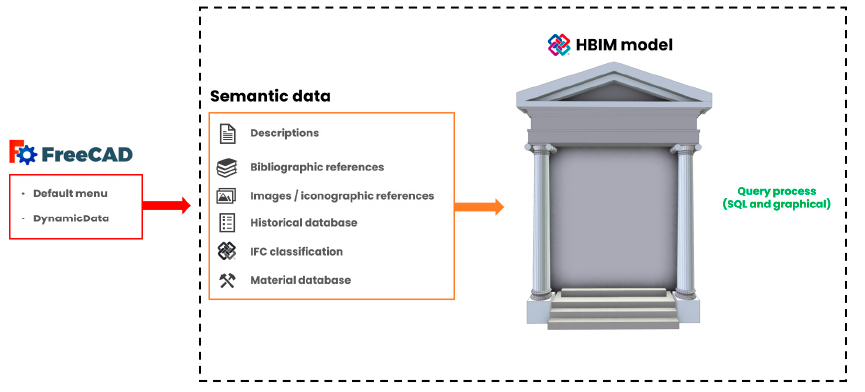
Figure 8. Semantic data inclusion is essential for query processes. Default menu and DynamicData WB allow to enrich the parametric model with technical and historical information.